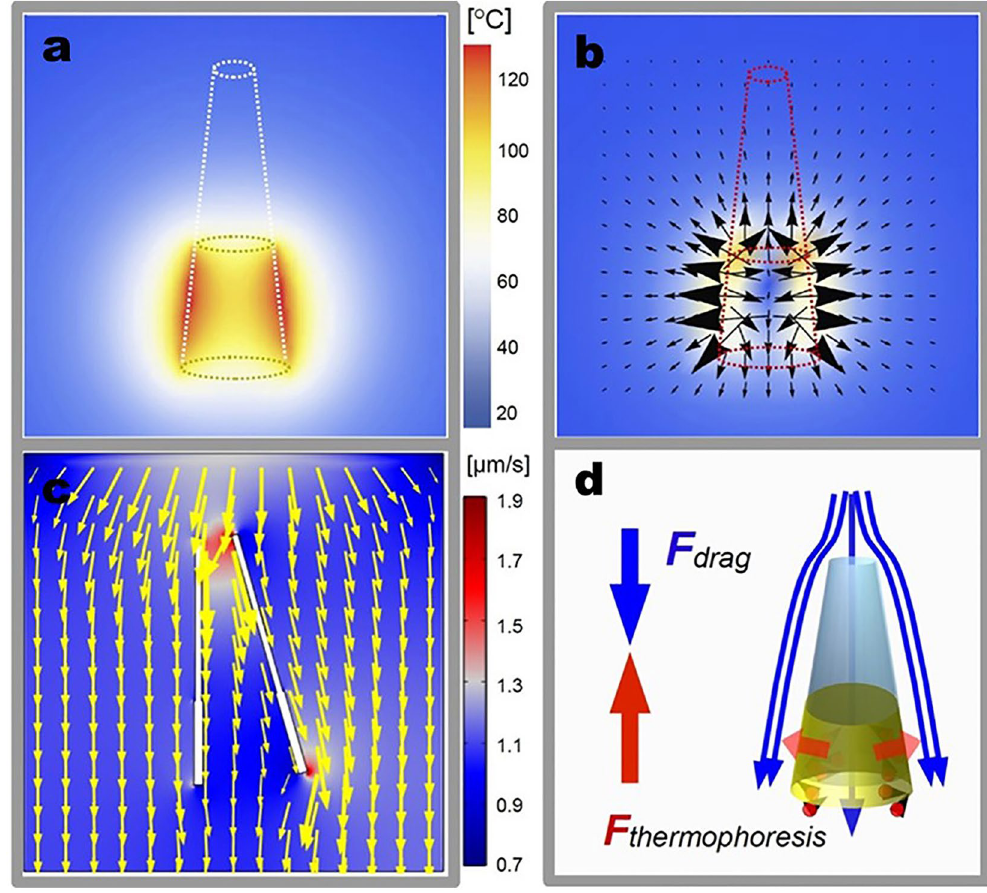
Figure 4. Theoretical Simulation of the NIR-Driven Propulsion of the Torpedo Motor. ( a ) The local temperature around the asymmetric torpedo with its tail covered by Au film on both inner wall and outside wall. ( b ) The computed thermophoresis force distribution around the cylinder Au shell, F thermophoresis . The black arrows indicates the force vectors, its size is proportional to the strength of the force. The degree of the color indicated absolute value of the force at that spatial point. ( c ) The velocity field distribution of fluid around a moving torpedo. The maximum velocity is around the narrow mouth and the tip of the wide tail. ( d ) The scheme of forces acting on the torpedo. The thermophoresis force (the red arrows pointing upward) pushes torpedo forward. While the drag force (the blue arrows pointing upward) due to viscous force of aqueous environment slows down the